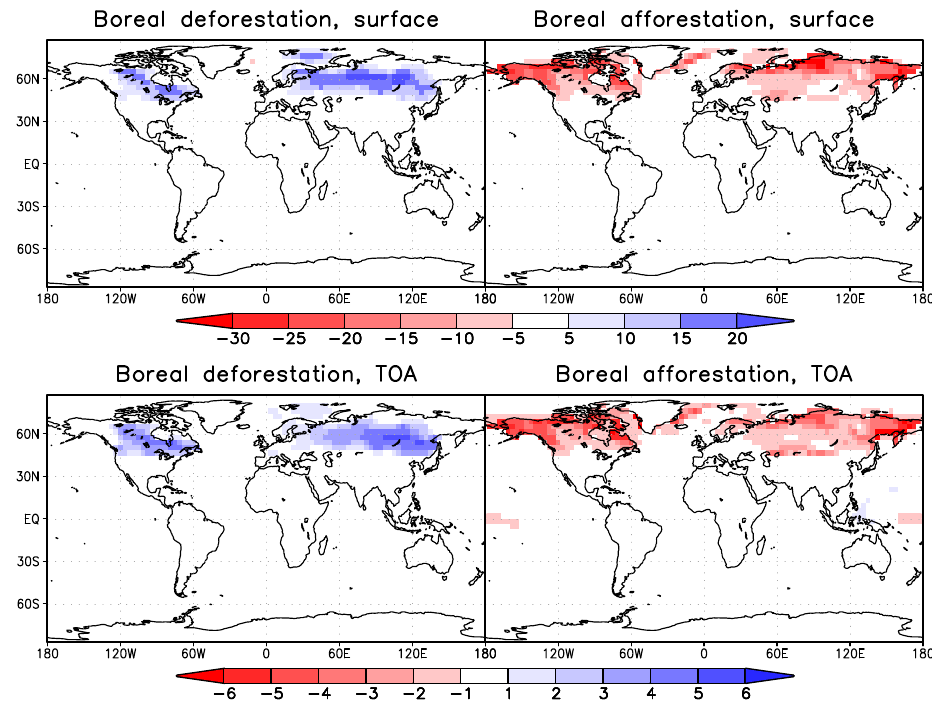
Fig. 11. Anomalies in surface albedo (top) and planetary albedo (bottom) in %, averaged over the final 200years for boreal deforestation (left) and boreal afforestation (right).